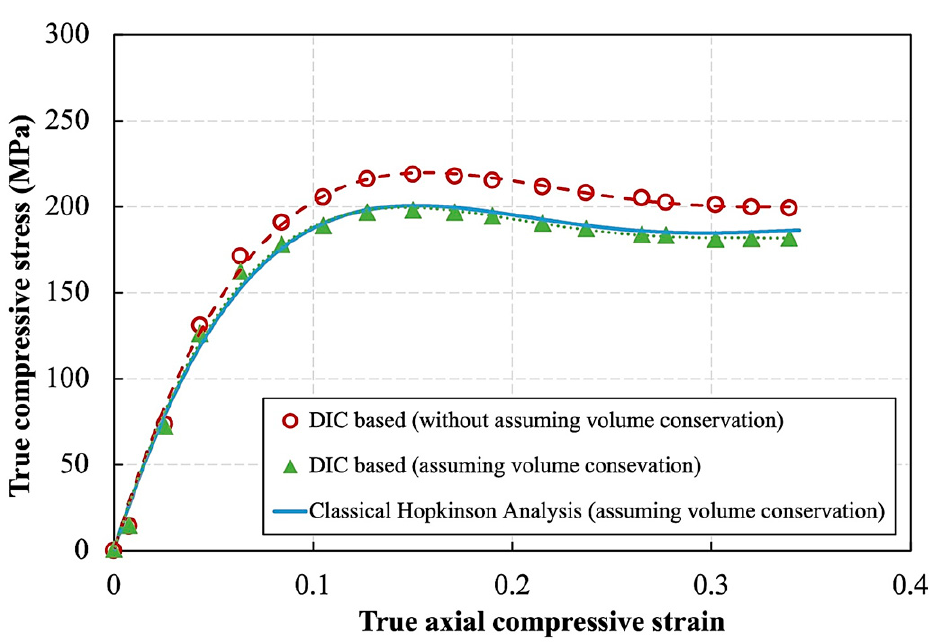
Figure 12. True stress–true strain curve of a high strain rate compression experiment on the epoxy resin.